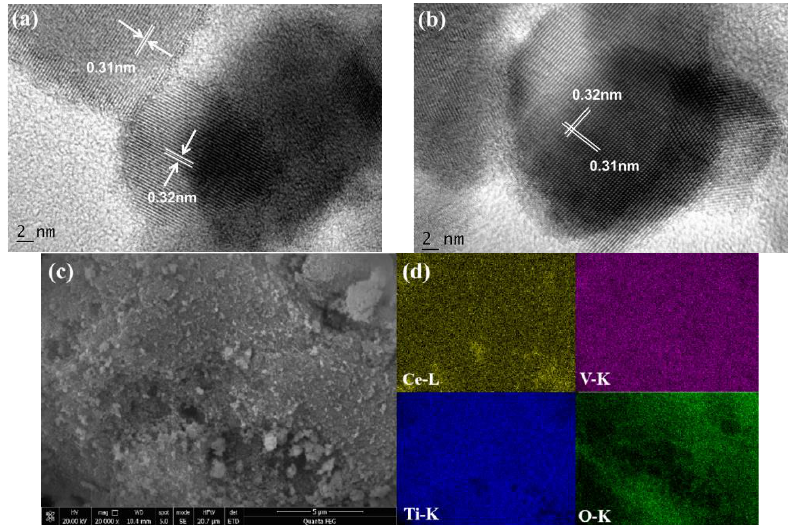
Figure 2. HR-TEM image ( a , b ) and SEM-EDS mapping images ( c , d ) of V-Ce oxides supported on TiO 2 (VCT). Table 1. Textural properties of di ff erent